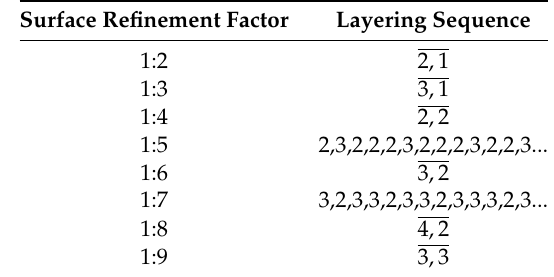
in Figure 7. The first level of refinement is identical to the cases for a 1:4 surface refinement factor since no normal layers have been refined. In the second level, however, two radial splits are performed in the normal layers as opposed to one. In the next level of refinement, which is not shown, normal layers would not have any radial refinements per the proposed sequence in Table